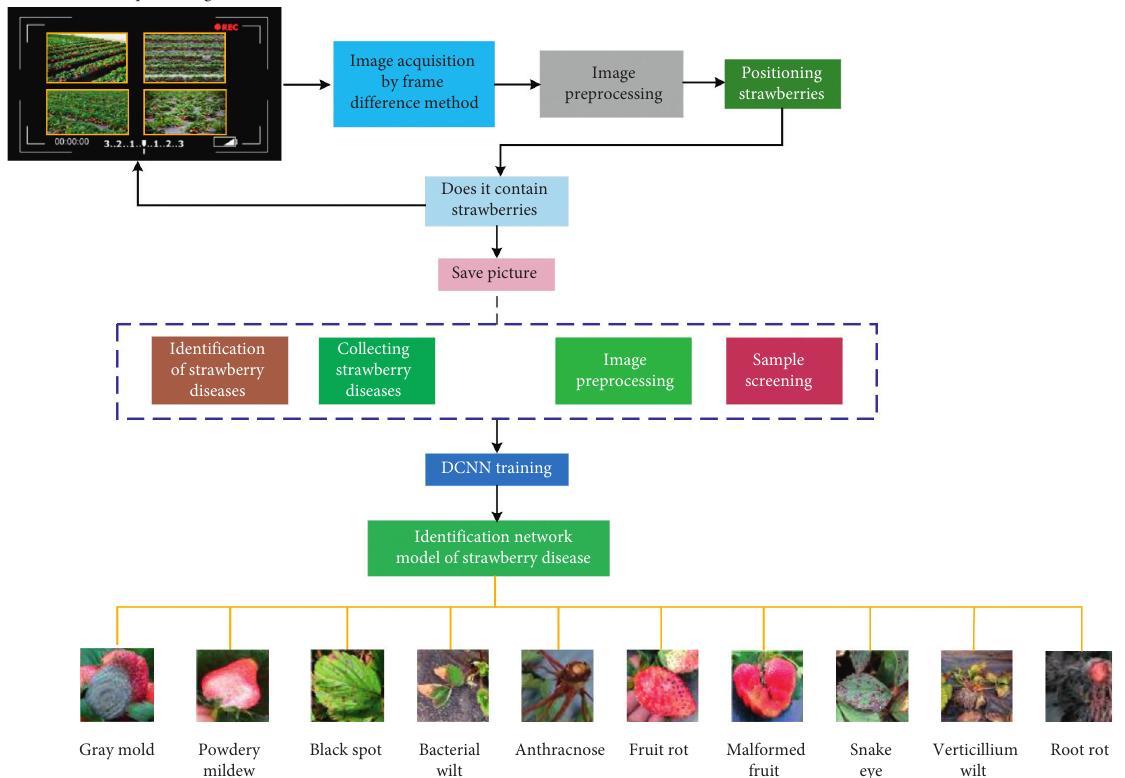
Figure 4: Flow chart of strawberry disease identification.